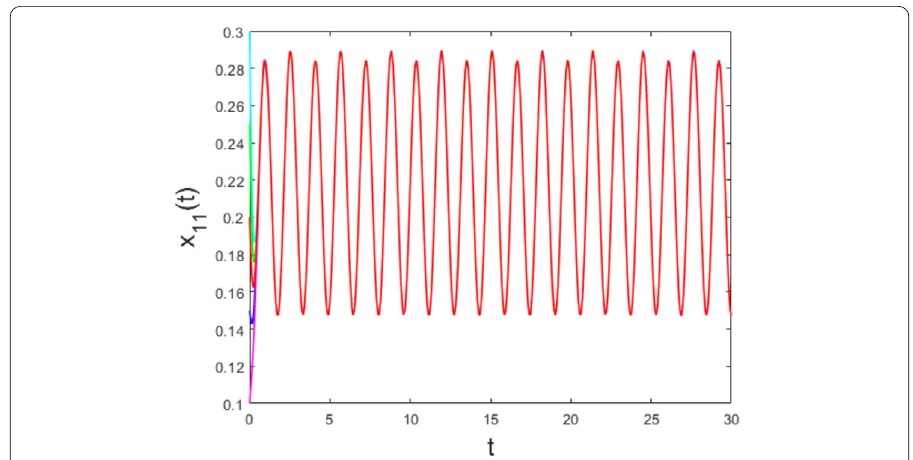
Figure 1 The state trajectory x 11 ( t ) of the network (11) with the initial conditions x 11 ( t ) = 0.1,0.15,0.2,0.25,and 0.3 for t ∈ [–1,0]. It is seen that the FSICNN (11) has a globally exponentially stable π -periodic